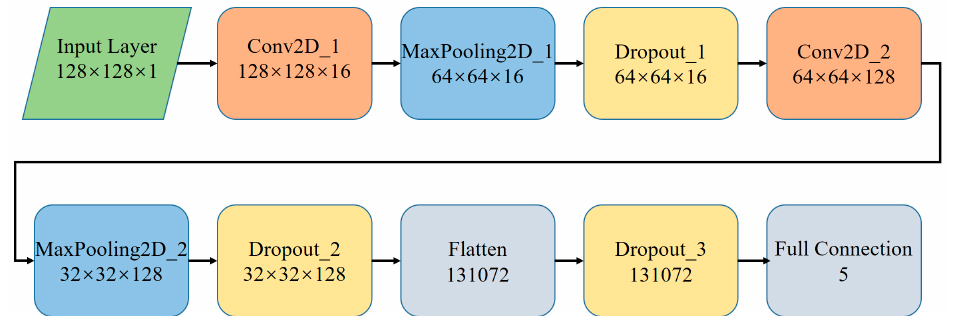
Figure 1. The network structure of the CNN classification model. The number below indicates the size of matrix of each layer.